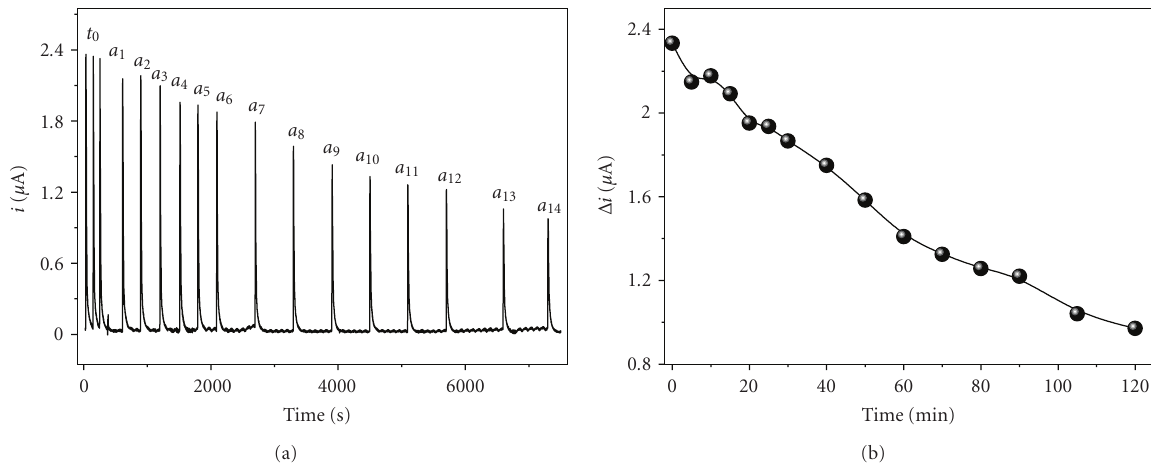
Figure 4: (a) Signals obtained at real-time as a function of the degradation time. t 0 : no current is applied. a 1 – a 6 : samples injected every 5min; a 7 – a 12 : aliquots of samples injected at 40, 50, 60, 70, 80, and 90 minutes after the electrolysis; a 13 and a 14 : aliquots injected at 105 and 120 minutes of electrolysis, respectively. [Paracetamol] 0 = 1.35 × 10 − 2 molL − 1 (2041.2molL − 1 ). (b) Response profile at real-time for the electrochemical degradation of paracetamol.